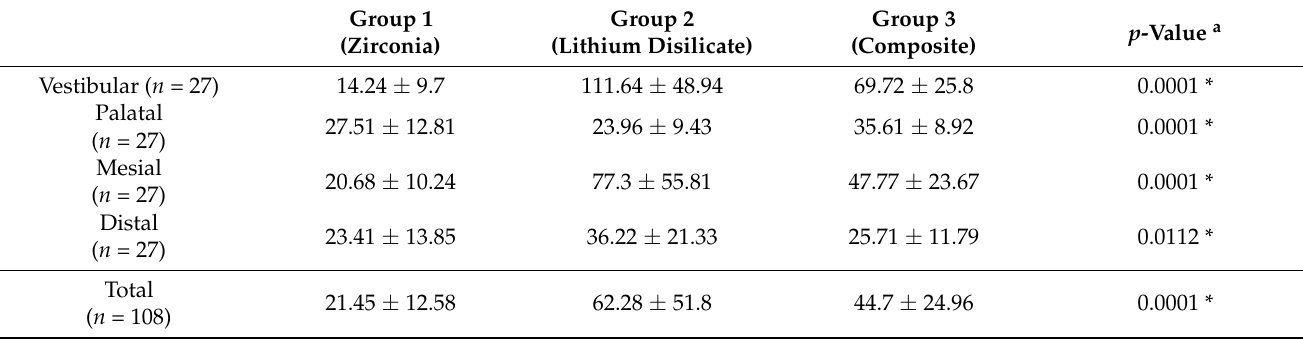
Table 2. Mean and standard deviation ( µ m) of the gap between restoration and abutment.